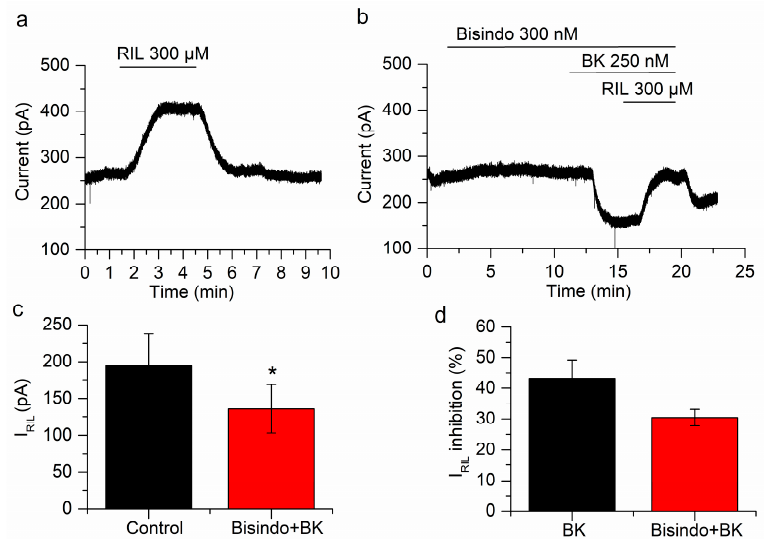
Figure 6. Protein kinase C (PKC) does not affect the inhibition of I RIL by BK. ( a ) Current activated by riluzole in control conditions. ( b ) In the presence of the PKC blocker bisindolylmaleimide both I -30 and I RIL are inhibited by BK. ( c ) The difference between I RIL (black bar) and I RIL in the presence of bisindolylmaleimide and BK (red bar) is statistically significant ( p < 0.05; n = 4). ( d ) The inhibition of I RIL by BK in presence of bisindolylmaleimide (red bar) is similar to the inhibition by BK alone (black bar; p = 0.17). Recordings in ( a , b ) belong to the same neuron. * p < 0.05.